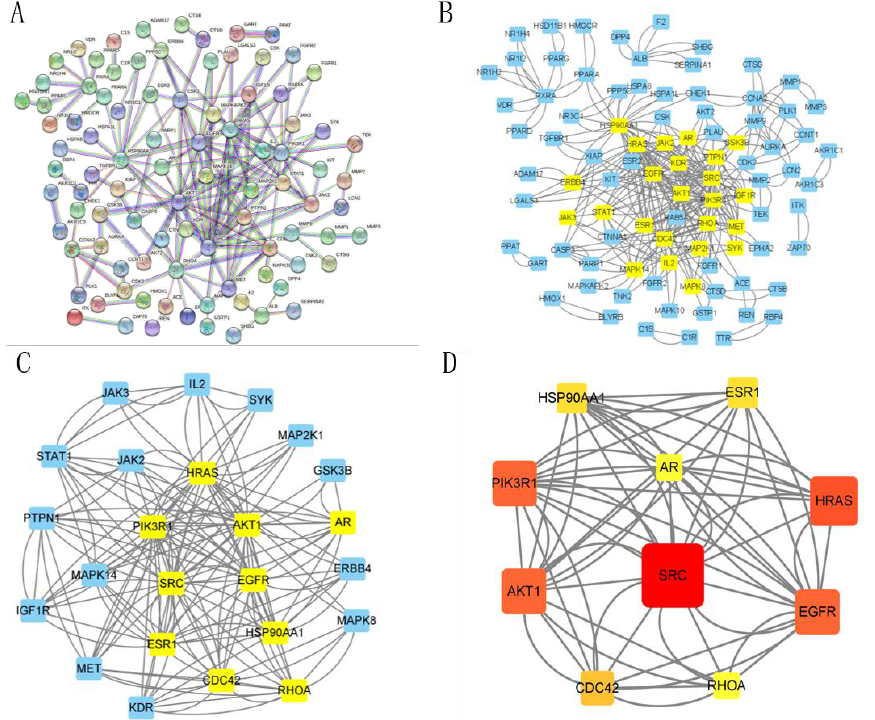
Figure 2. PPI network of BDMC-UC. ( A ) The interactive PPI network derived from STRING database. ( B ) PPI network obtained from STRING database to Cytoscape3.8.0. ( C ) PPI network of more important proteins extracted from ( B ) by filtering six parameters: BC, CC, DC, EC, NC, and LAC. ( D ) Core PPI network of key proteins extracted from ( C ). Higher degree values indicate larger node sizes, red represents a higher degree, and yellow represents a lower degree.